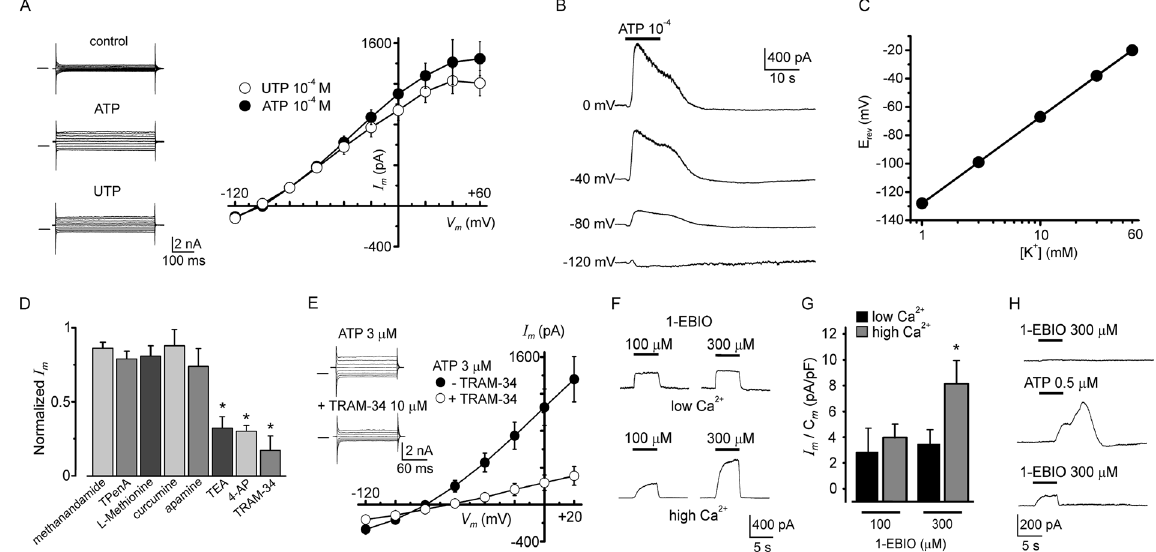
Figure 4. Ionic basis of the outward current elicited by ATP and effect of K + channel modulators. ( A ) Current responses obtained by applying voltage pulses, from − 120 to + 60 mV in 20 mV steps, to a SKOV-3 cell held at − 40 mV. Currents during superfusion in control conditions (upper traces) and at the outward component peak elicited either by ATP (middle traces) or UTP (lower traces). Control currents were subtracted from those obtained at the peak response, and the amplitude values were plotted against the respective membrane voltage; the linear I/V relationship obtained (23 cells) showed a reversal membrane potential close to − 100 mV. ( B ) Traces illustrate an example of current responses elicited by ATP while a cell was held at different values as indicated, confirming a linear I/V relationship and the E rev estimation for the outward component. ( C ) Relationship between E rev (estimated as in ( A ) and external K + concentration; line is the Nernst relationship considering internal and external concentrations in each case. Data represent means ± SEM of 10–15 cells. ( D ) A battery for distinct K + -channel inhibitors was tested on the response, including non-specific blockers of K + channels (TEA + and 4-AP), those specific for two-pore K + channels, and blockers apamin and TRAM- 34 specific for K Ca 2 and K Ca 3.1, respectively; bars indicate the proportion of current inhibited by the different antagonists ( * p < 0.05). ( E ) Traces show membrane current recorded during the outward peak response to ATP (upper traces) and that obtained in the same cell by co-applying ATP together with TRAM-34 (10 µ M), a specific blocker of K Ca 3.1 channels (lower traces). The graph shows data (means ± SEM) obtained in 30 cells under the same protocol in which the basal currents were subtracted for each case, averaged and plotted. ( F ) Currents elicited by 1-EBIO (100 or 300 µ M), a K + channel opener specific for K Ca 3.1 channels, applied at two different intracellular Ca 2 + concentrations: low and high (estimated concentration of 10 and 300 nM, respectively). The bar graph shows the averaged current density obtained in each condition monitored in 14 cells. ( G ) Traces illustrate a case in which initially, 1-EBIO was unable to generate any current (upper trace); however, after a response elicited by ATP, a second application of 1-EBIO (lower trace) at the same concentration generated a meaningful outward